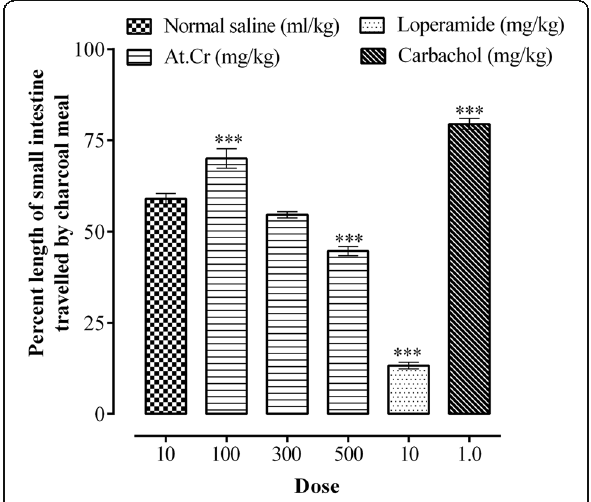
Fig. 1 Effects of Asphodelus tenuifolius crude extract (At.Cr), loperamide and carbachol upon charcoal meal transit in small intestine of mice. Values are mean ± SEM ( n = 5). *** p < 0.001 versus saline treated control